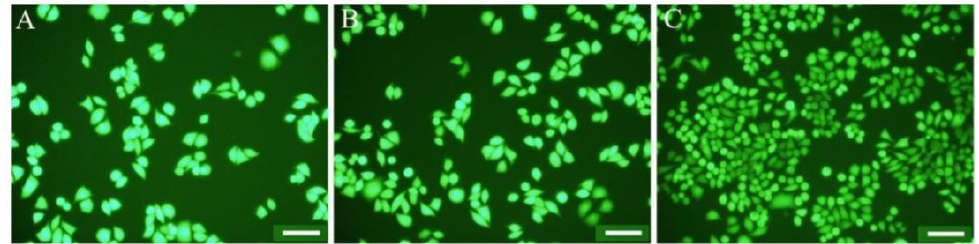
Figure 3. Photographs of L929 fibroblast cells incubated for 3 days on PCL fibers ( A ), PCL/CNT fibers ( B ), and CS-PCL/CNT fibers ( C ). Note: scale bars are 100 µm [84].